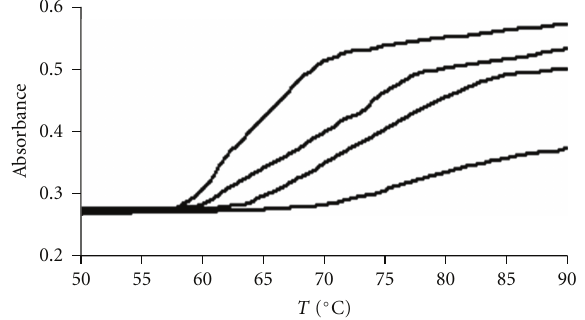
Figure 3: Melting curves of CT-DNA (5 × 10 − 5 M) in the absence and in the presence of Pt complex at various r i = [Complex]/[DNA] = 0.0, 0.1, 0.2, 0.4 in Tris-HCl (10mM), pH = 7.2.